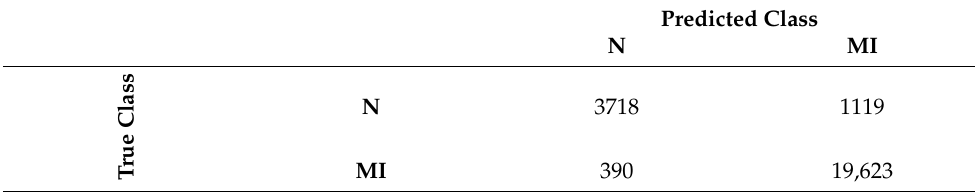
Table 6. Confusion matrix for normal and MI classes in Setting 2.